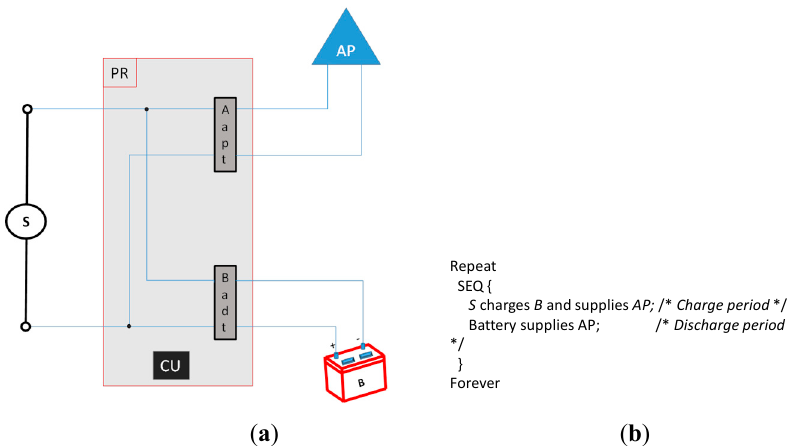
Figure 1. ( a ) Graphic schema of the wireless fidelity access point (WiFi AP) and main components of our novel mechanism for energy saving. ( b ) Processing model: chained alternating charge and discharge periods.